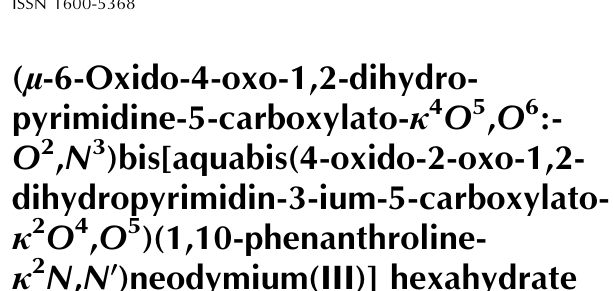
Bruker APEXII diffractometer Absorption correction: multi-scan